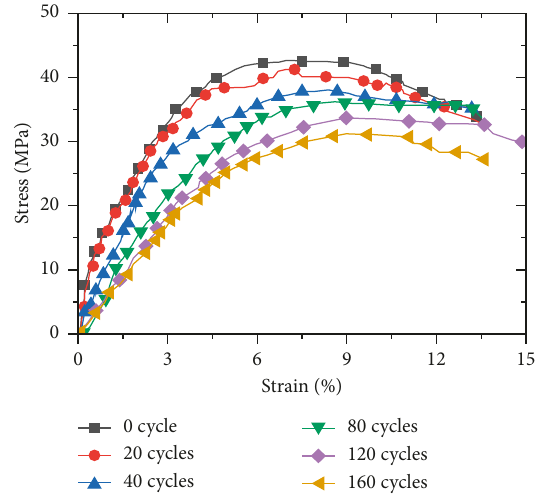
Figure 5: The relationship between stress and strain (Na solution, i.e., SE2 specimen).